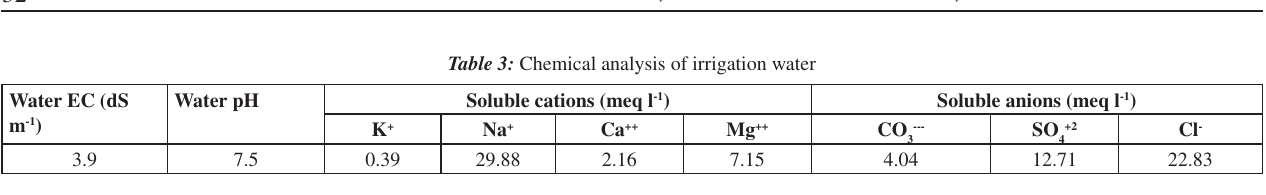
Table 4: Some vegetables, their storage conditions, and material used for analysis (adapted from Kevers et al. 2007 ) Vegetable